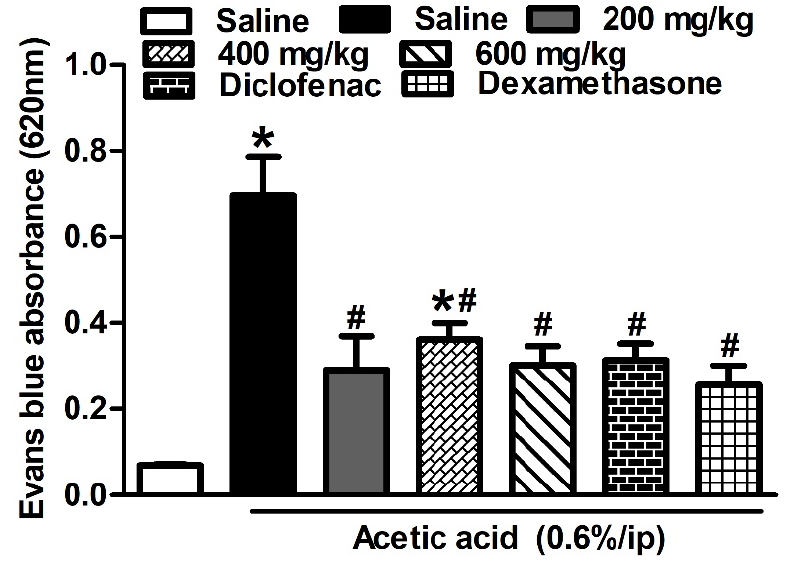
Figure 4. E ff ect of H. campechianum flower extract tested doses (p.o., 200, 400 and 600 mg / kg) on vascular permeability induced by acetic acid in mice relative to diclofenac (p.o., 20 mg / kg) and dexamethasone (p.o., 2 mg / kg). Evans blue dye absorbed in the peritoneal cavity was measured to indicate the degree of inflammation. The values are presented as mean values ± SEM (n = 5–6). * p < 0.05 compared to the saline group. # p < 0.01 compared to the control group (treated with acetic acid